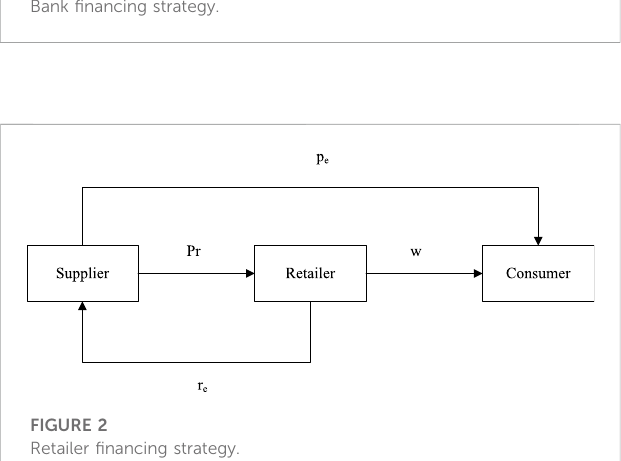
FIGURE 1 Bank fi nancing strategy.